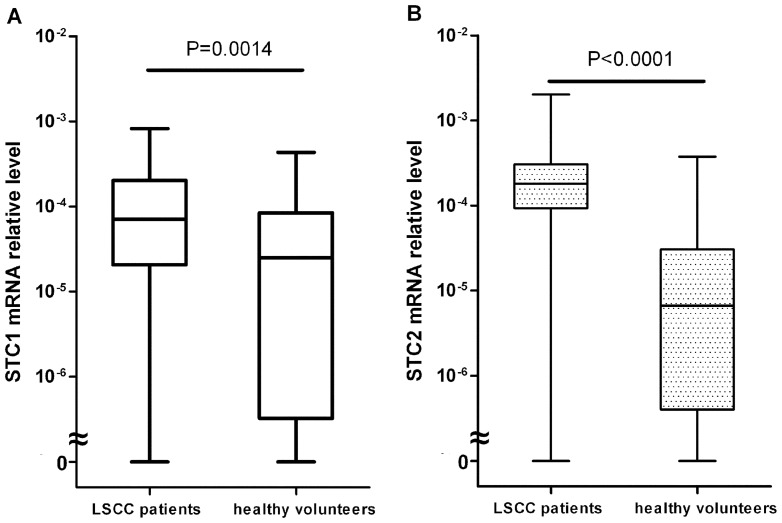
STC1 and STC2 mRNA in peripheral blood from LSCC patients (n = 62) and healthy volunteers (n = 30).Circulating STC1 (A) and STC2 (B) mRNA levels were significantly higher in LSCC patients than those of healthy volunteers as determined by quantitative real-time PCR (both P<0.05, Mann-Whitney test). The heavy, black, horizontal line in each box represents the median value.